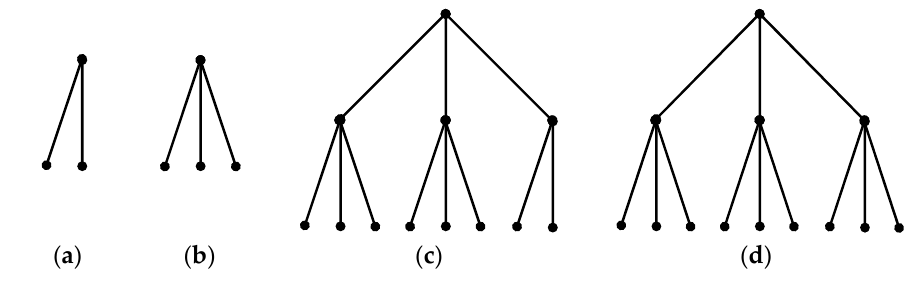
Figure 3. Code trees for n = 3: ( a ) | A | = 2; ( b ) | A | = 3; ( c ) | A | = 8; ( d ) | A | = 9.